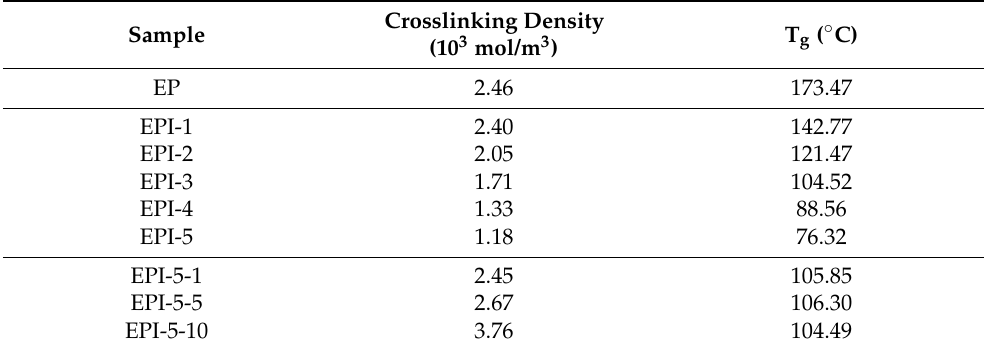
Table 2. Crosslinking density of cured epoxy/polyimide blends by dynamic mechanical analysis (DMA) in N 2 gas